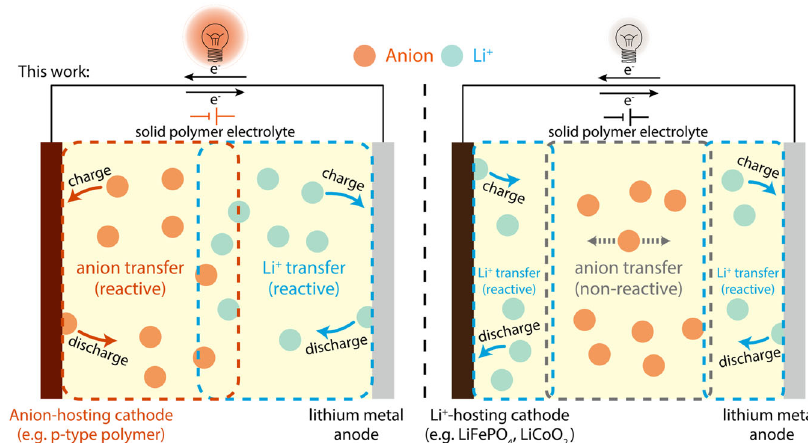
Fig. 1 Anion and cation migration and electrode reaction in two different battery systems. The ions transfer in SPEs of all-solid-state batteries using different ion acceptors as the cathode (left: anion-hosting cathode (this work), e.g., p-type polymer, right: Li + -hosting